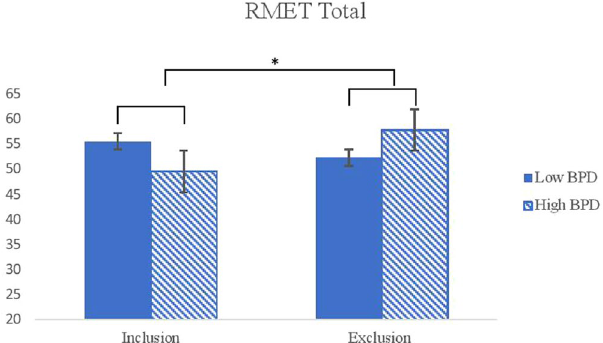
Figure 5. Interaction effects between conditions and the level of BPD features on the RMET total score. Note . BPD = Borderline Personality Disorder. RMET = Reading the Mind in the Eyes Test. * p < 0.05 , ** P < 0.01